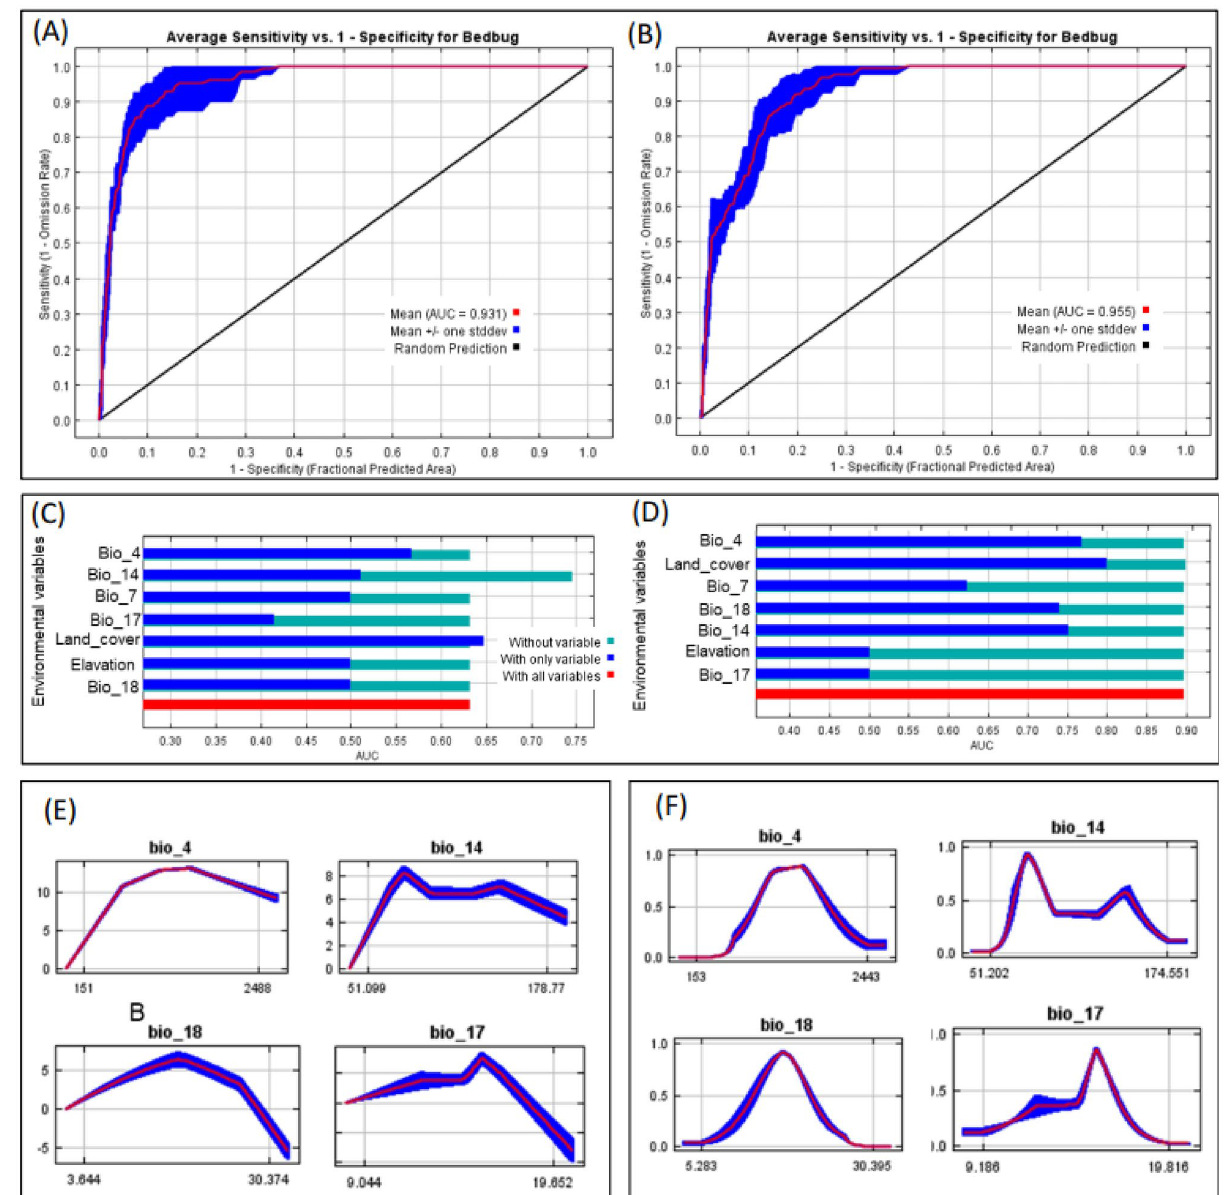
Figure 6. Receiver Operating Characteristic (ROC) curve verification of the predicted potential habitat for bedbug in Kenya ( A ) and in Africa ( B ); the relative importance of environmental variables for predicting the suitability habitat of bedbugs in Kenya ( C ) and Africa ( D ) and response curves between the probability and environmental variables in Kenya ( E ) and in Africa ( F